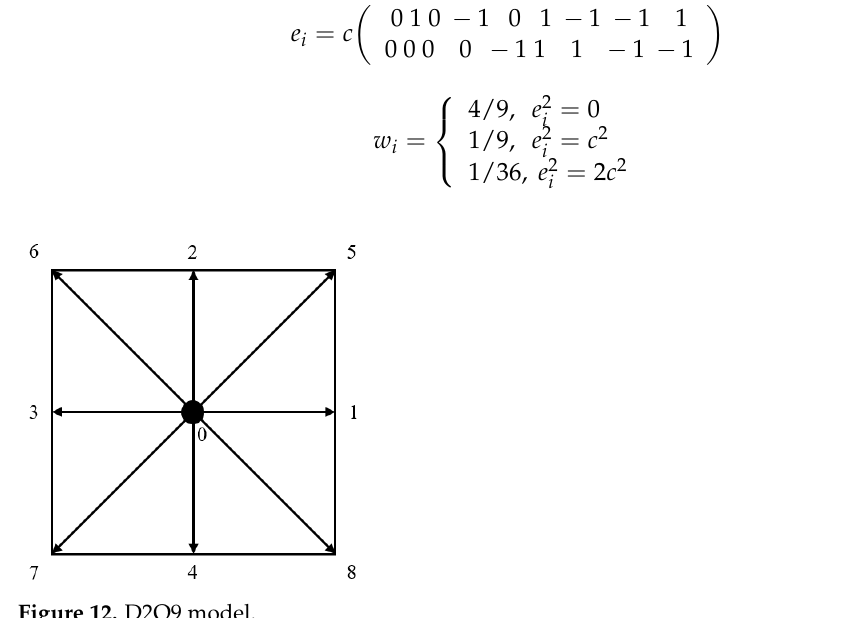
Figure 12. D2Q9 Figure 12. D2Q9 model.